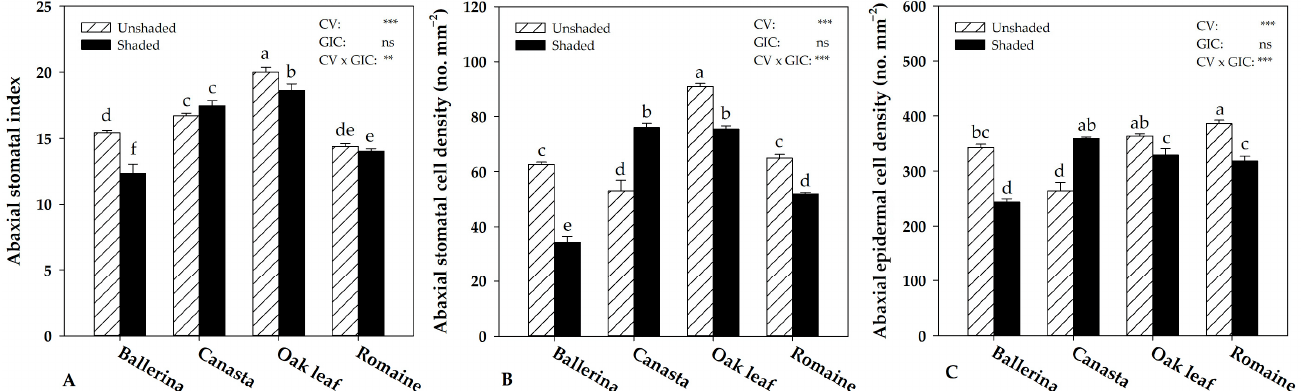
Figure 3. Effect of Cultivar (CV) and Greenhouse Irradiance Conditions (GIC) on morpho-anatomical traits of abaxial side of Lactuca sativa L. Stomatal index ( A ), stomatal cell density ( B ), and epidermal cell density ( C ). Data are mean values ± standard error, n = 3. Mean comparisons were performed by Duncan’s Multiple Range Test (DMRT) for CV and by t -Test for GIC. Different letters indicate significant differences compared by DMRT ( p = 0.05). ns, **, and *** denote nonsignificant or significant effect at p ≤ 0.01 and 0.001, respectively.